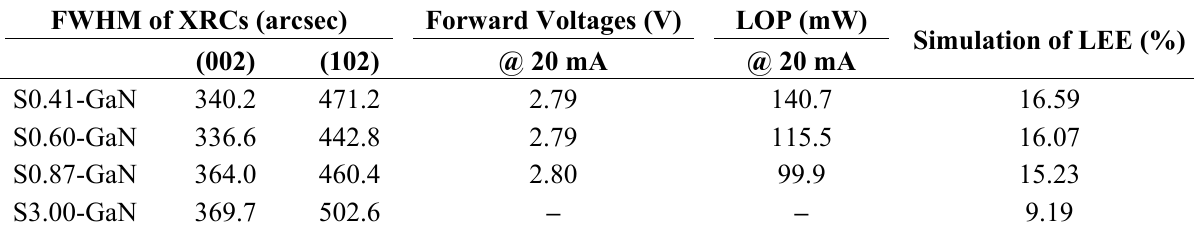
Table 2. Characteristics of